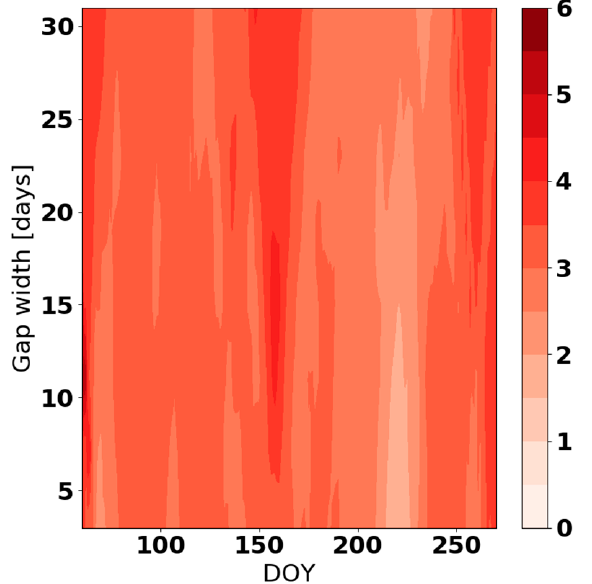
Figure 8. Standard deviation of the observed data which are used for bias correction for DOY 60–273 in 2014 in Kikinda (Serbia).